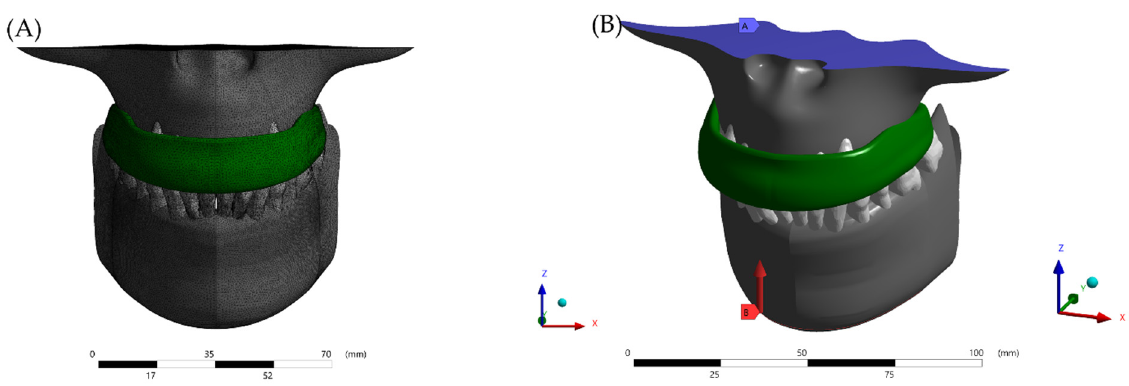
Figure 4. Boundary conditions in the finite element model. ( A ) Meshing subdivision after the convergence analysis and ( B ) fixed support with occlusal force in Z-axis.